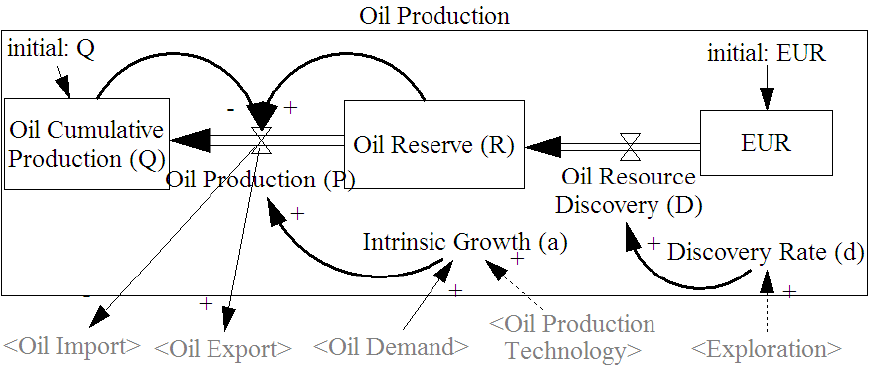
Figure 4. Stock and flow structure of oil production sub-module. Thin arrows indicate influence from or toward factors within the same loop but from different sub-modules. Dashed arrows indicate influence from a parameter or a factor that belongs to other